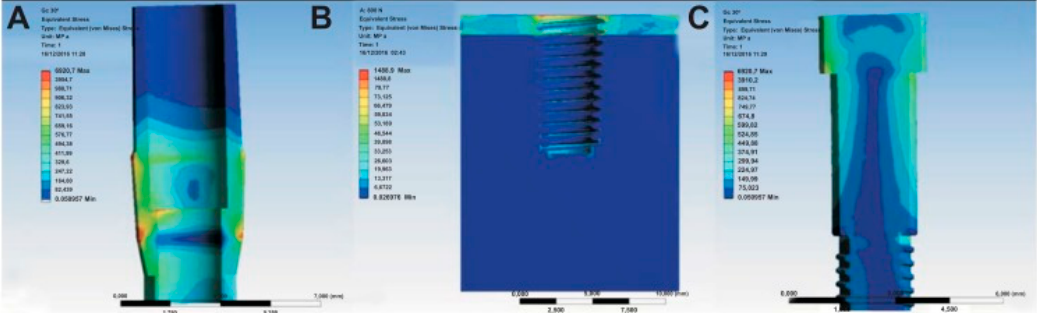
Figure 3. Adapted from [1] with permission of Prof. A. Nanci and Dove Press in 2018. Biofilm adhesion on different surfaces: ( A ) dental implant smooth surface; ( B ) dental implant mesoporous surface on the right.